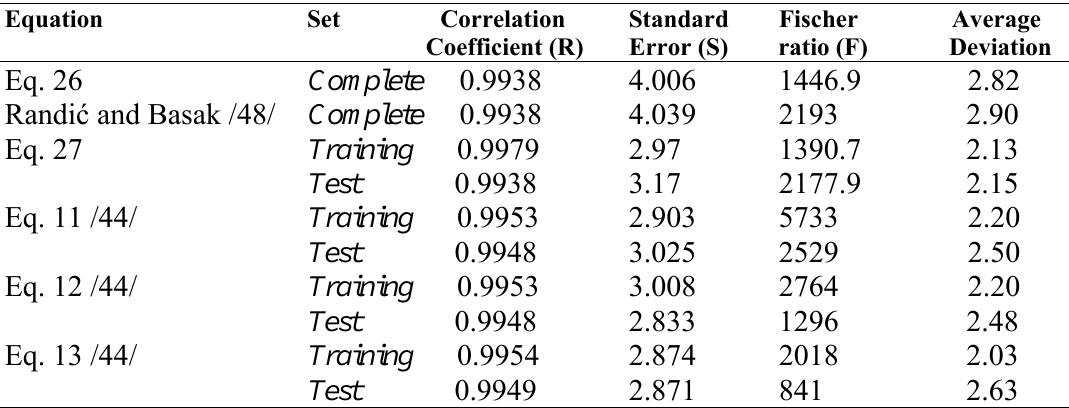
Table 7 . Statistical Parameters Corresponding to the Regression